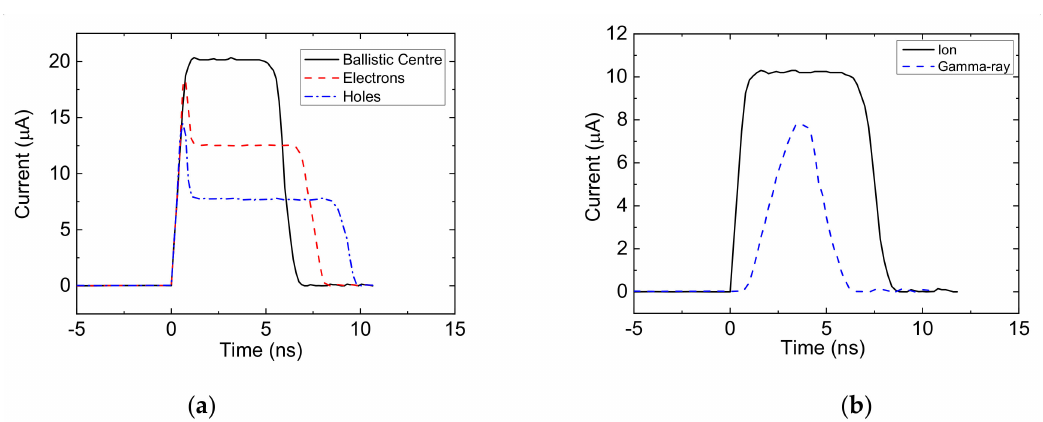
Figure 12. ( a ) Pulse shapes produced by carriers generated in different position inside the diamond bulk; ( b ) rectangular and trapezoidal/triangular pulses produced by ion and gamma-ray, respectively, in